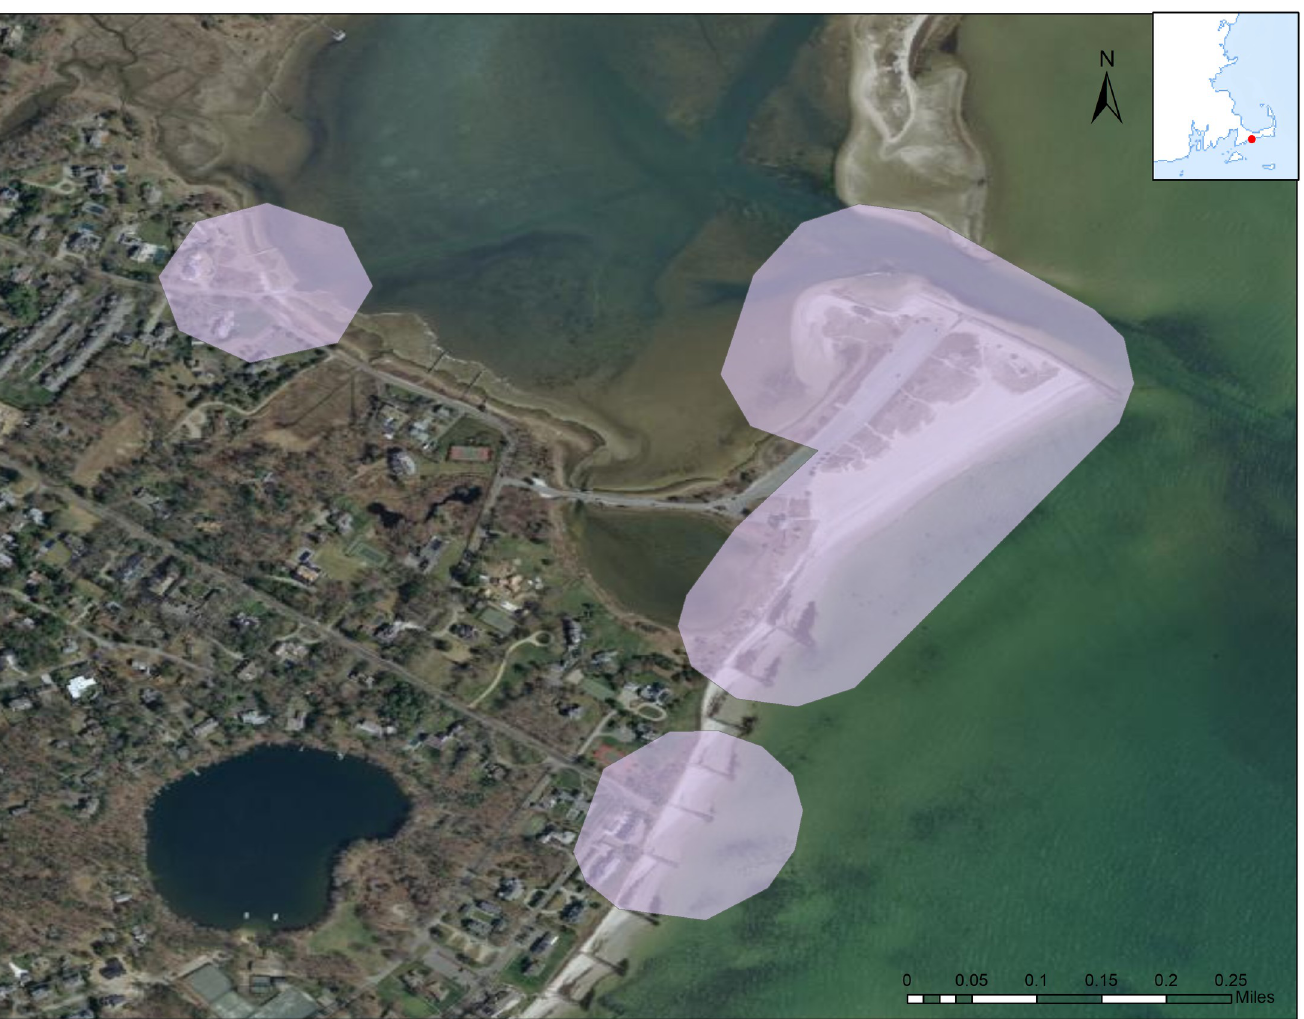
Fig 1. Example definition of water recreation areas. Dowses Beach, Barnstable, Massachusetts, USA and nearby water access areas. Point and line features representing water recreation access were buffered by 100 meters to capture use at the sites. These geographic areas correspond to the sample of visitation estimates from the cell